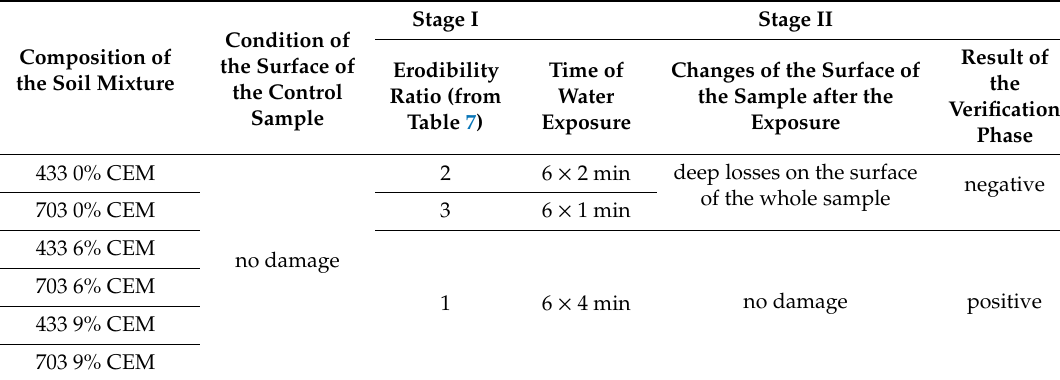
Figure 9. Two samples from a 703 mixture not containing cement. Left: sample not tested for water absorption, right: sample after 30 min of exposure in water. During the first 28 days, all of the samples were seasoned under conditions of a high relative humidity of 95%. After that, part of the samples series was dried to a constant mass, while the second